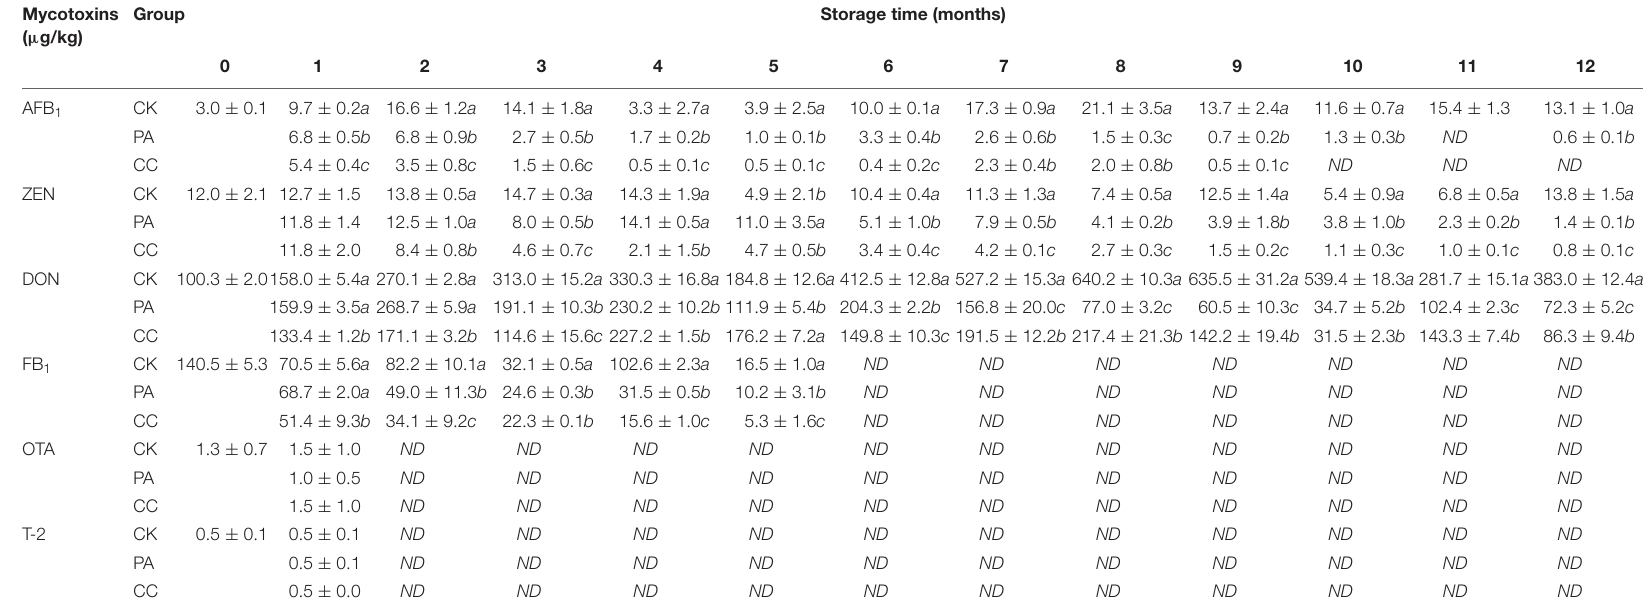
∗ ND, not detected. Different lowercase letters in each column indicate a significant (P < 0.05). AFB control group; PA, propionic acid treated group; CC, essential oils treated